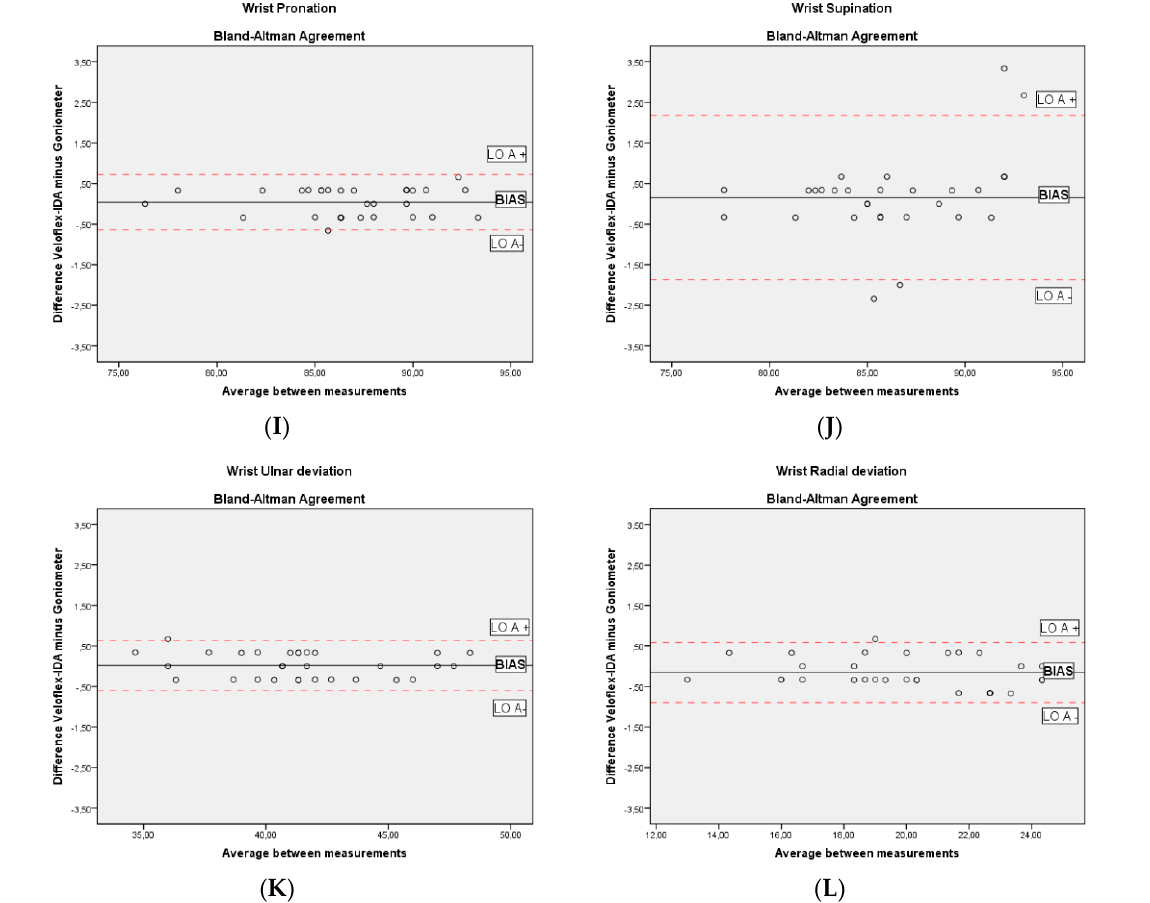
Figure 2. Bland–Altman plots for Veloflex infrared dynamic angle-meter (Veloflex-IDA) and goniometer during ( A ) shoulder flexion; ( B ) shoulder extension; ( C ) shoulder internal rotation; ( D ) shoulder external rotation; ( E ) shoulder abduction; ( F ) elbow flexion; ( G ) wrist flexion; ( H ) wrist extension; ( I ) wrist pronation; ( J ) wrist supination; ( K ) wrist ulnar deviation; ( L ) wrist radial deviation.